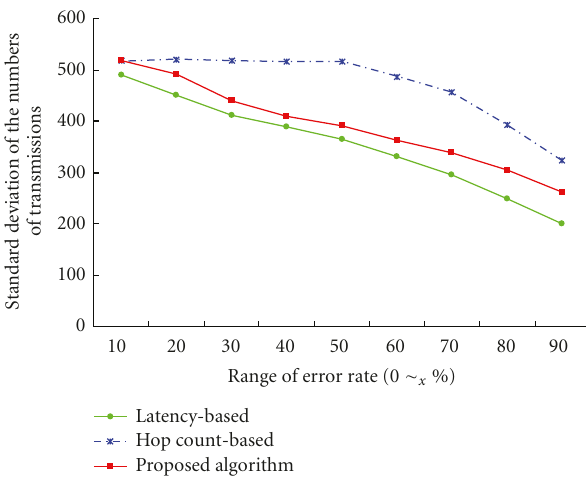
Figure 9: Standard deviation of the packet